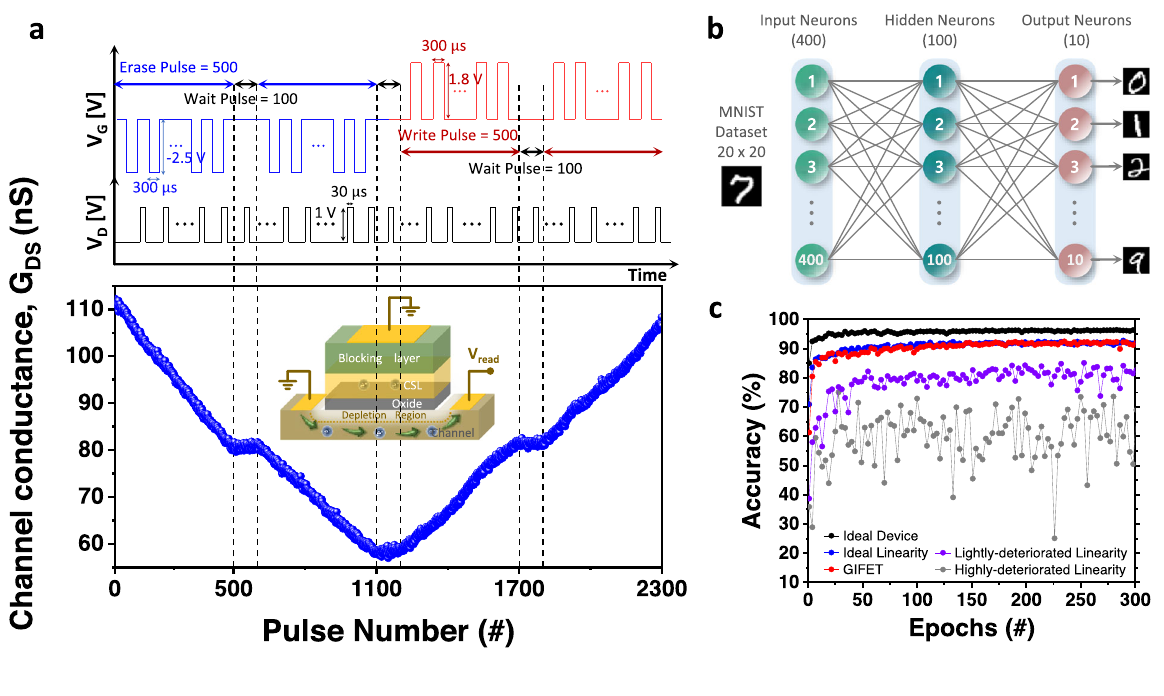
Fig. 5|GIFET simulationwithMNISTdataset.a The fastreadspeedof theGIFET. The graph shows the LTP-LTD characteristics of the GIFET cell with 1V, 30 μ s read pulses(write/erasewith1.8V/ − 2.5V,300 μ s). b Thecon fi